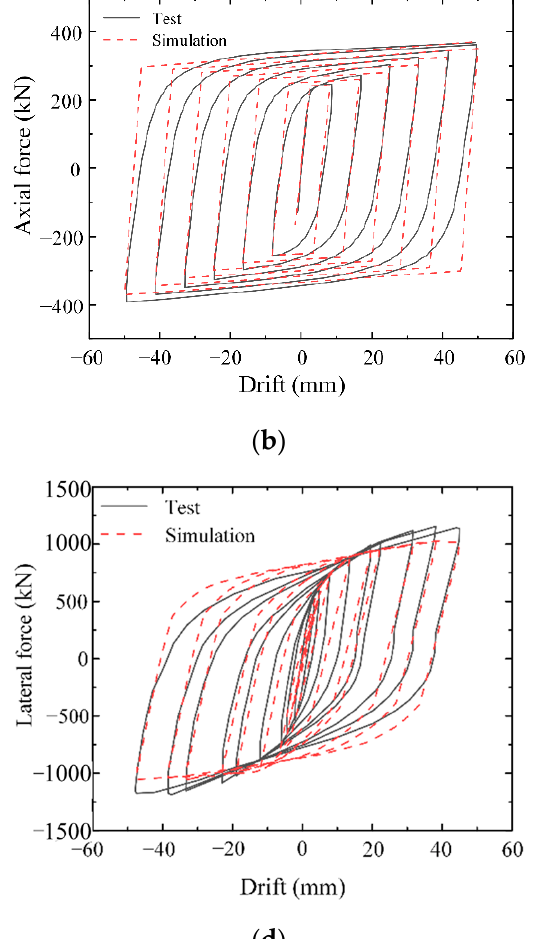
Figure 6. Sketch diagram: ( a ) BLY225-1, ( b ) V1, ( c ) V2, ( d ) BRBCF3, and ( e ) BRBF3 and BRBF5.